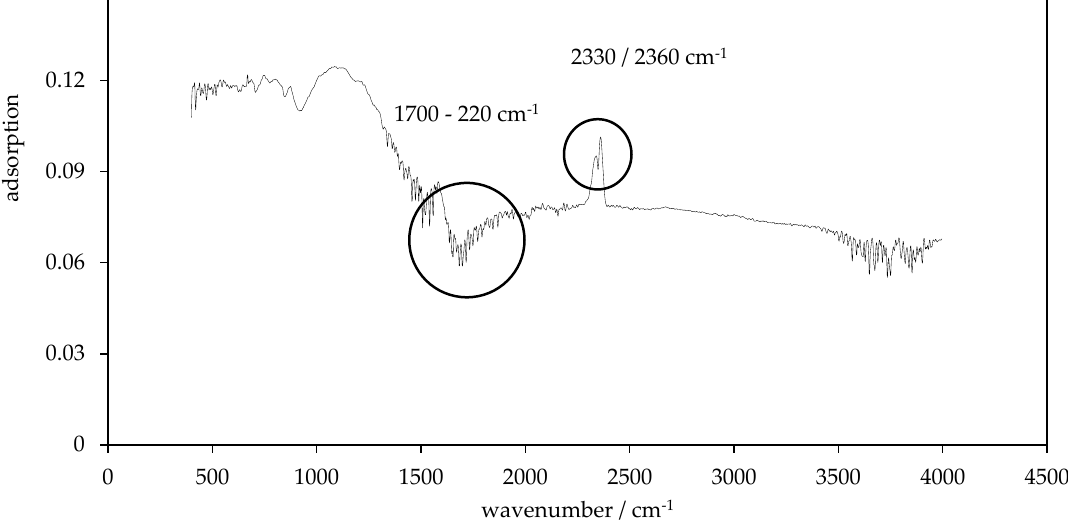
Figure 11. FTIR spectrum of char P600-240-5.